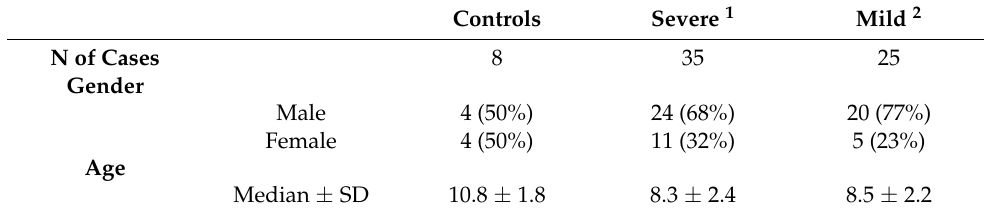
Table 1. Summary of cohort demographic characteristics.